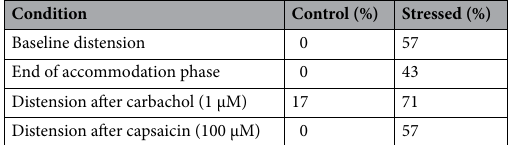
Table 2. Percentage of control and stressed bladders exhibiting phasic contractions of the bladder during various conditions.